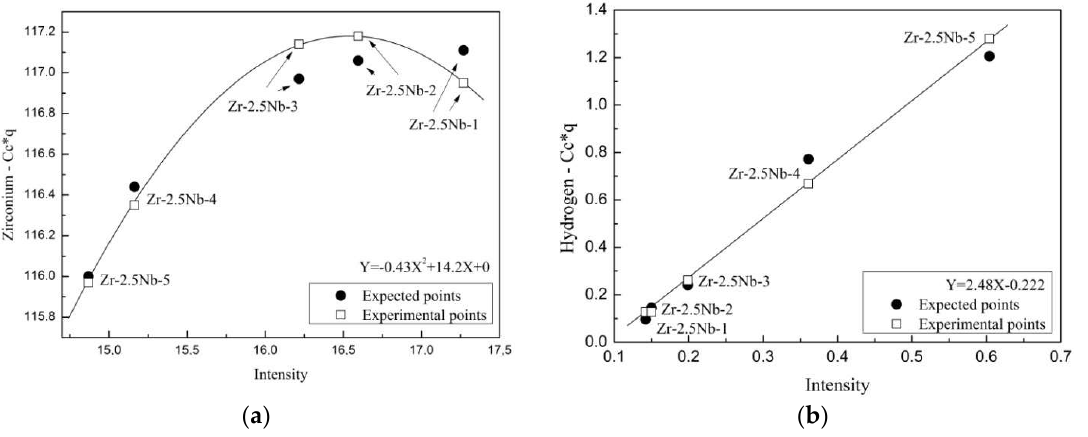
Figure 4. Calibration curves of ( a ) zirconium (339.203) and ( b ) hydrogen (121.574). Table 4. Results of the calibration with the usage of Zr-2.5Nb samples: C1—concentration which was used as average theoretical value, C2—determined concentration during the calibration, % wt—% in weight.